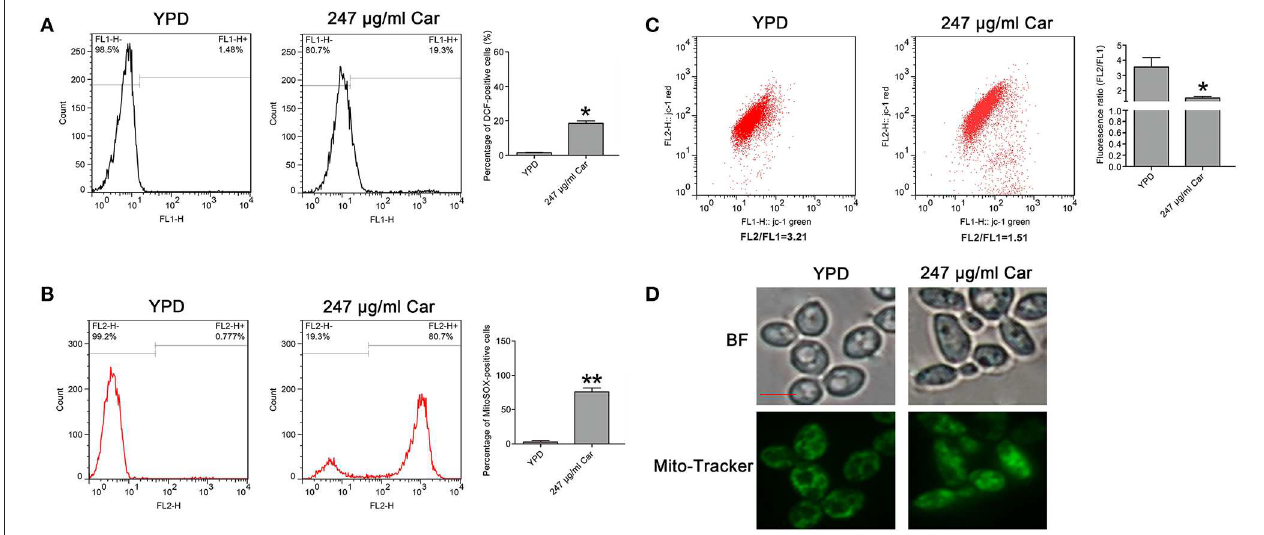
FIGURE 4 | Reactive oxygen species (ROS) level and mitochondrial function were examined in C. albicans cells after treatment with carvacrol. (A) ROS levels were analyzed using DCFH-DA staining. The histogram showed the percentage of DCF-positive cells, and data were shown as mean ± SD ( n = 3). * P < 0.05. (B) Mitochondrial ROS levels were determined by flow cytometry using a MitoSOX Red mitochondrial superoxide indicator. The histogram showed the percentage of MitoSOX-positive cells, and data were expressed as mean ± SD ( n = 3). ** P < 0.01. (C) The mitochondrial membrane potential was assessed using JC-1 staining. The histogram was the quantitative analysis of fluorescence ratio (FL2/FL1), and data was shown as mean ± SD ( n = 3). * P < 0.01. (D) Mitochondrial morphology was observed using Mito-Tracker Green. BF, Bright Field. Bar, 5 µ